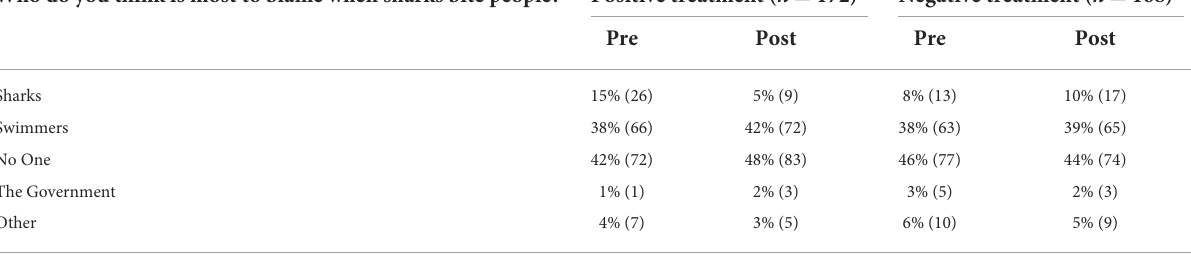
TABLE 4 Who is to blame when sharks bite people, broken down by